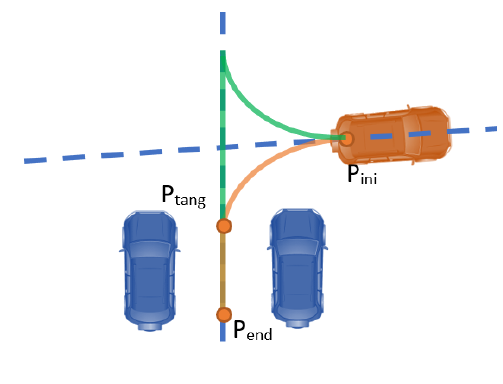
Figure 7. Battery parking trajectory generation